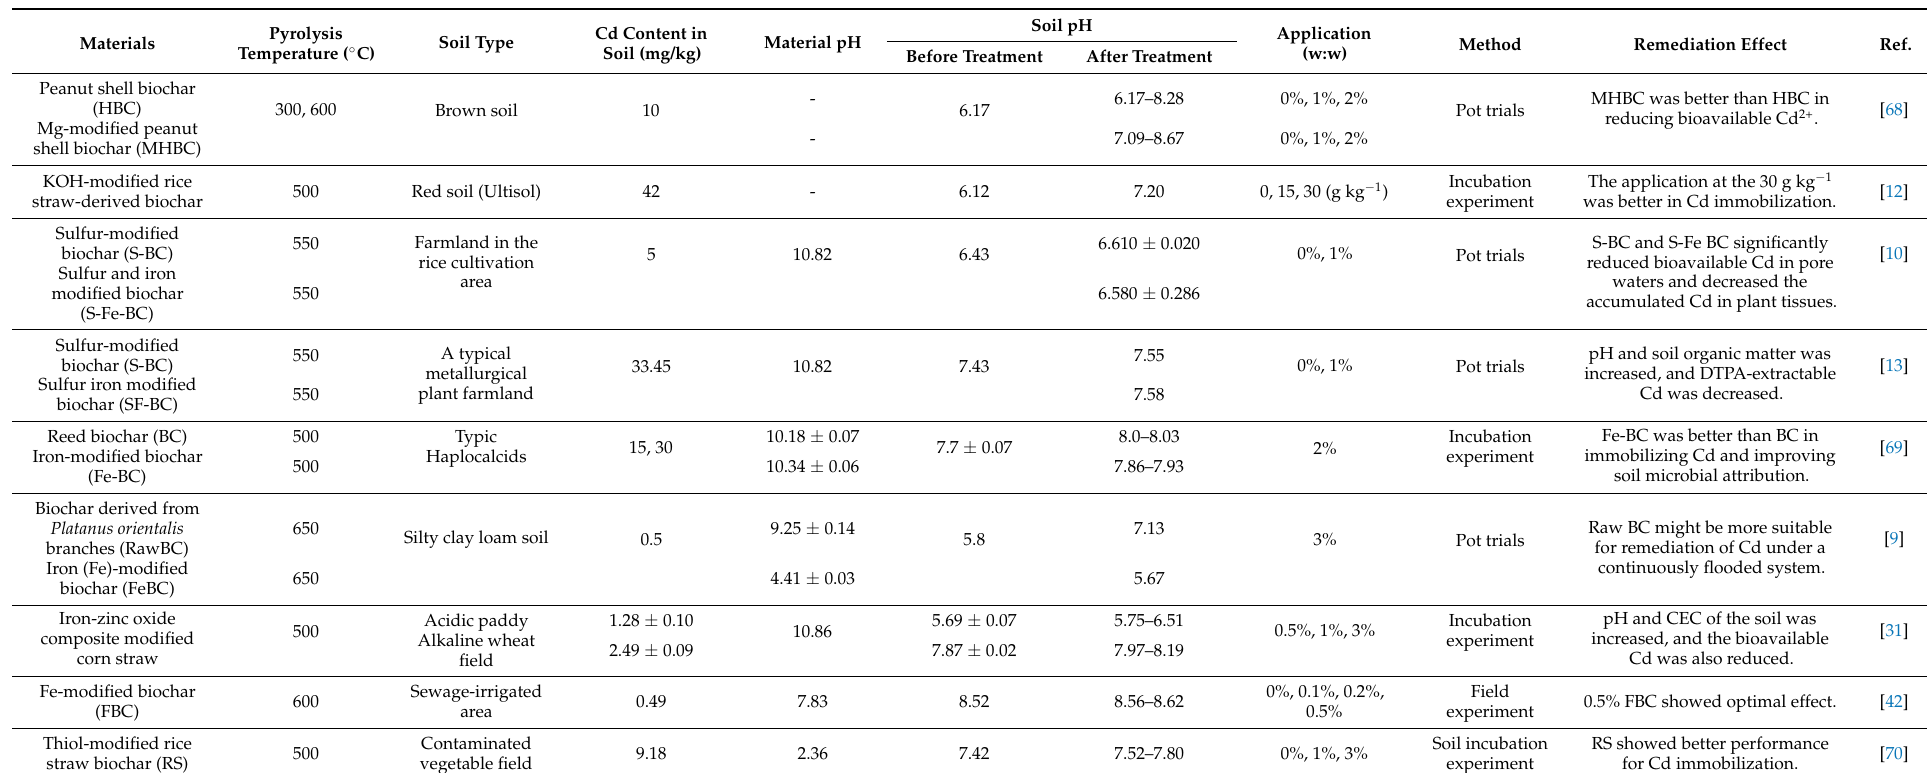
Table 3. Remediation of Cd-contaminated soils by chemically modified